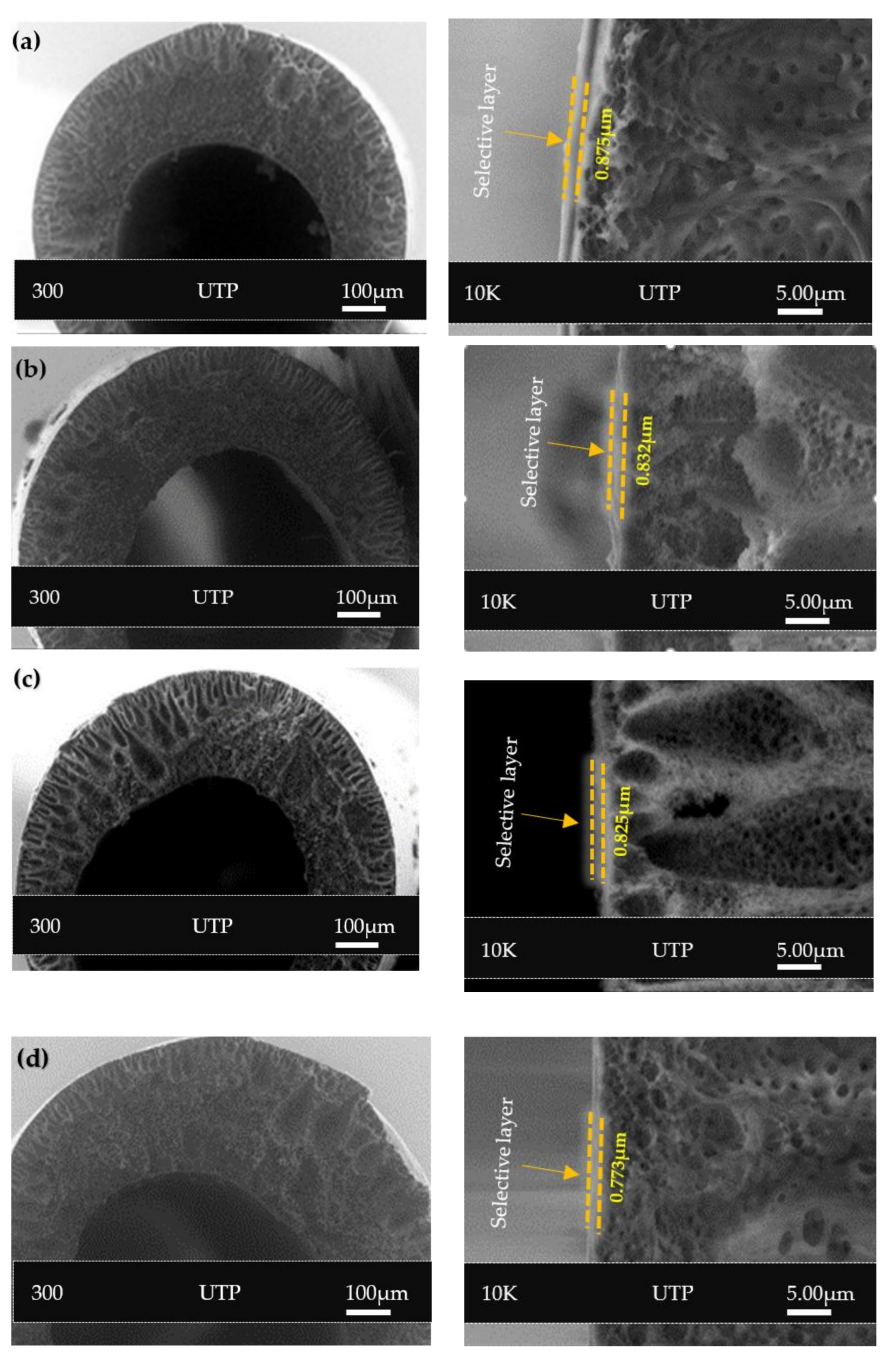
Figure 5. Cross-section morphology of composite hollow fiber membranes at 300 and 10 K magnifica- tions ( a ) C 5 , ( b ) C 10 , ( c ) C 15 , and ( d ) C 20